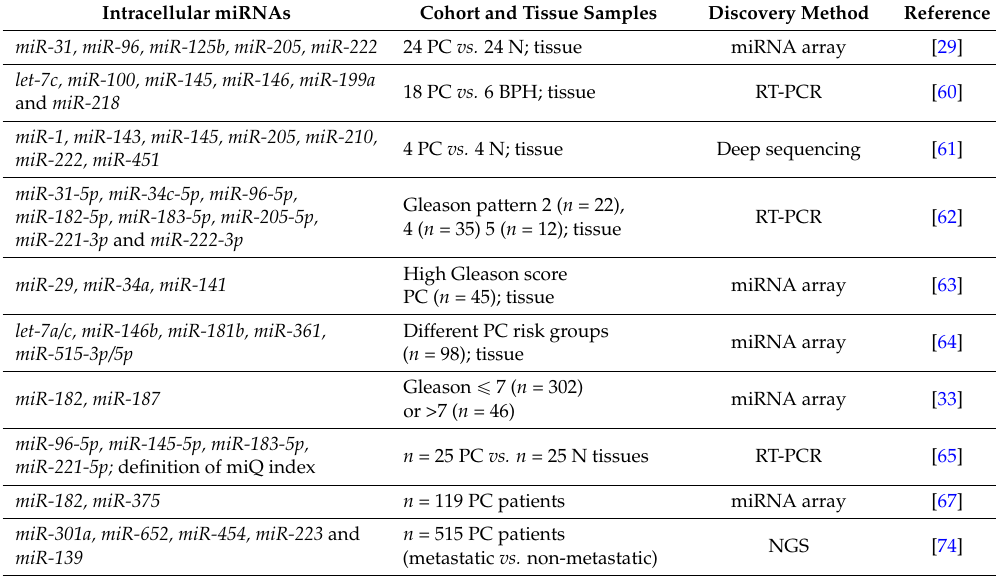
Table 2. miRNA selection with prognostic ability. Extracellular and intracellular prognostic miRNAs are indicated. NGS = next generation sequencing; PC= prostate cancer; N= normal